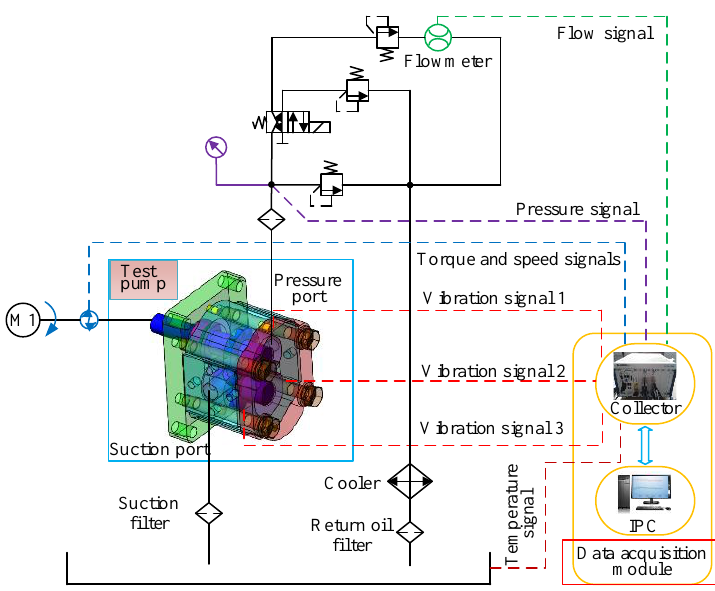
Figure 18. Schematic diagram of the test system.